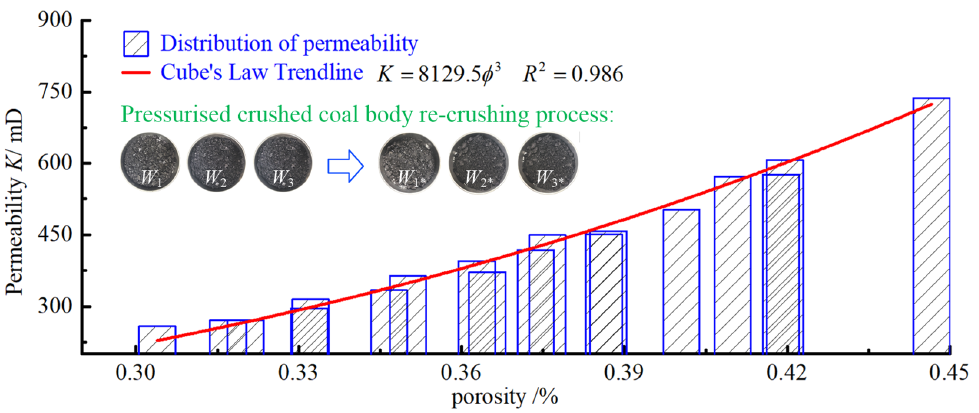
Figure 15. Effect of porosity on permeability.